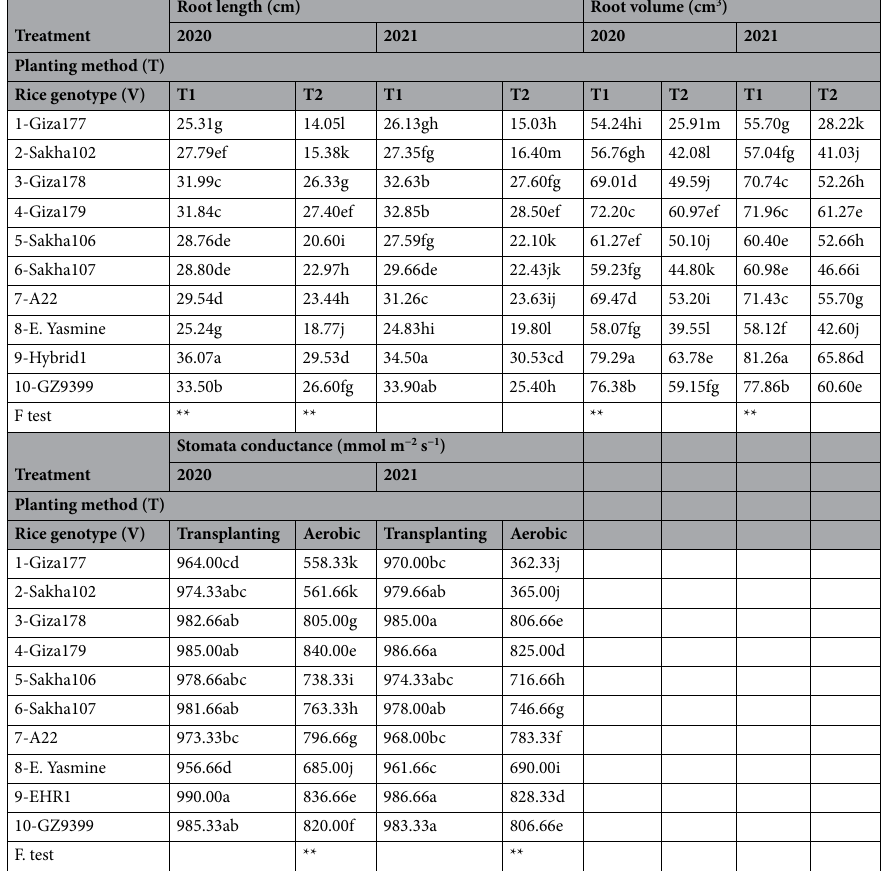
Table 10. Root length, root volume and stomata conductance as affected by the interaction between rice genotypes and planting methods. T1 = Transplanting, T2 = Aerobic, **Significant at 0.01 level. Means followed by a common letter at the same column are not significantly different according to Duncan ’ s multiple range at 0.05